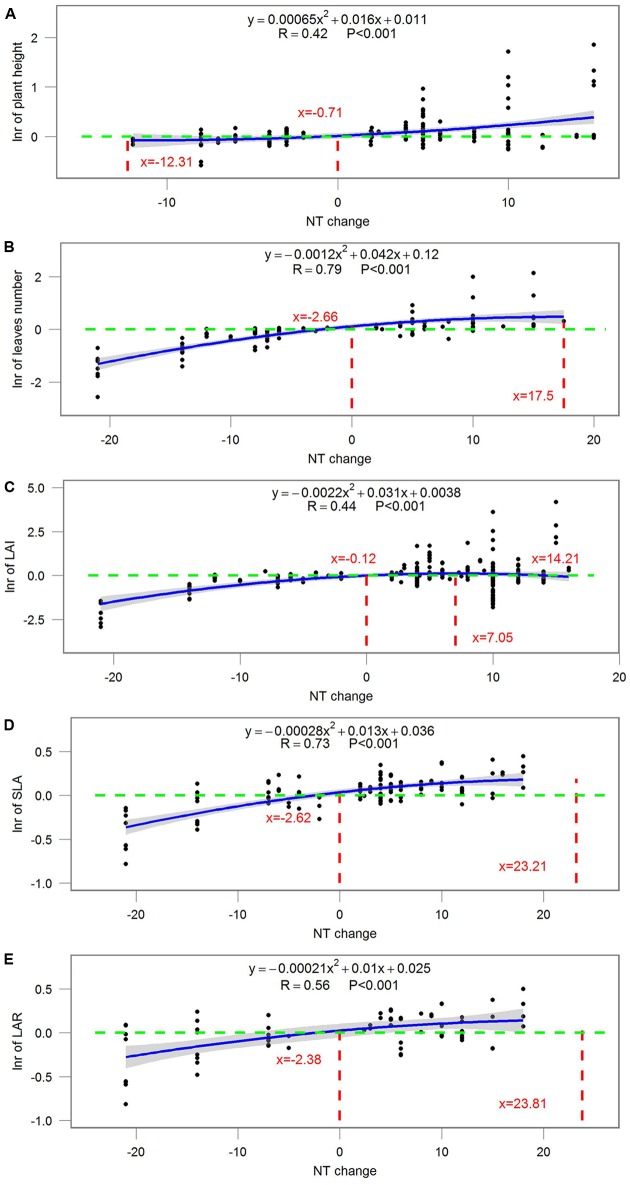
Correlations between the magnitude of NT treatment and the response ratio of (A) plant height; (B) number of leaves; (C) leaf area index (LAI); (D) specific leaf area (SLA); (E) leaf area ratio (LAR). Each point represents response ratio (lnr) to HNT or LNT. Regression function, variation coefficient and p-value are presented in the middle of each graph. Different lines indicate X = 0 (red line), x-value when y is the maximum, crossing points of y = 0 (green line) and regression relationships.